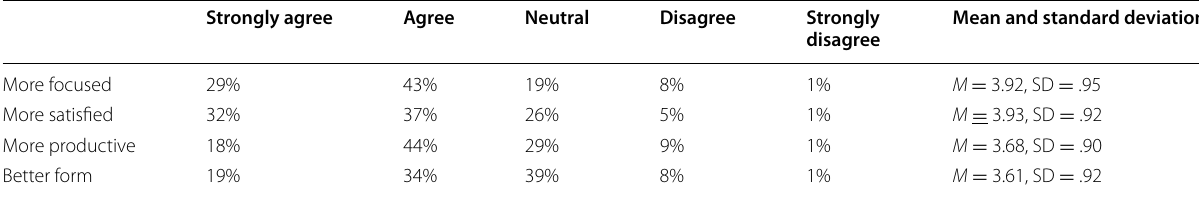
Table 3 How participants indicated they felt when comparing exercise with cannabis to exercise without on a 1–5 scale with 5 strongly agree and 1 strongly disagree ( n 101) = =